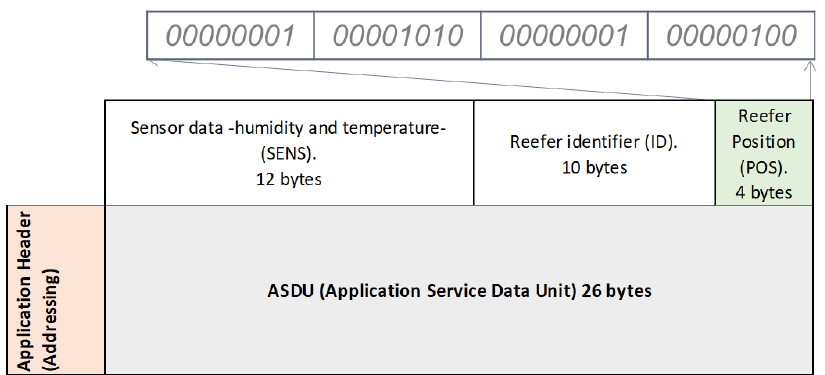
Figure 21. Detail of the message with the position of the container on the